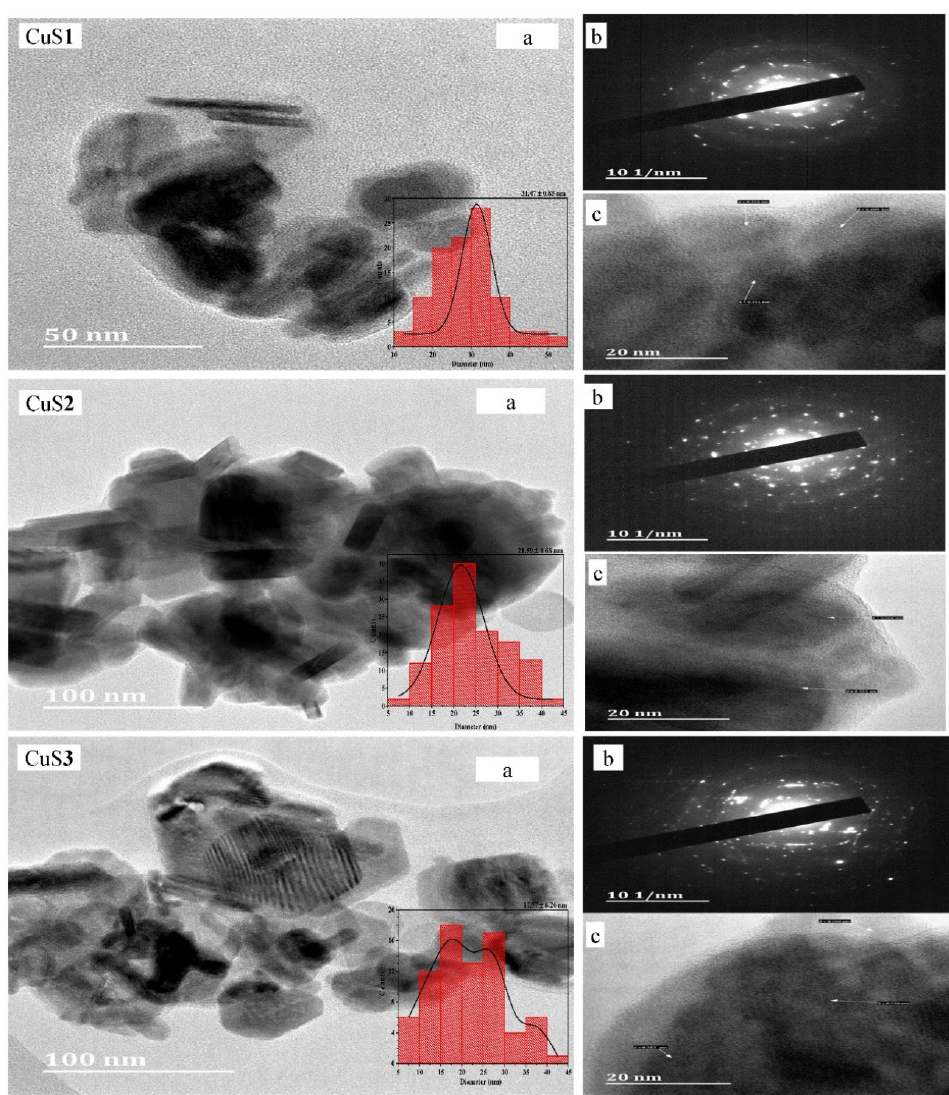
Figure 2. HRTEM images ( a ) SAED ( b ) and lattice fringes ( c ) and corresponding size distribution chart (insert) of CuS 1 , CuS 2 and CuS 3 nanoparticles.